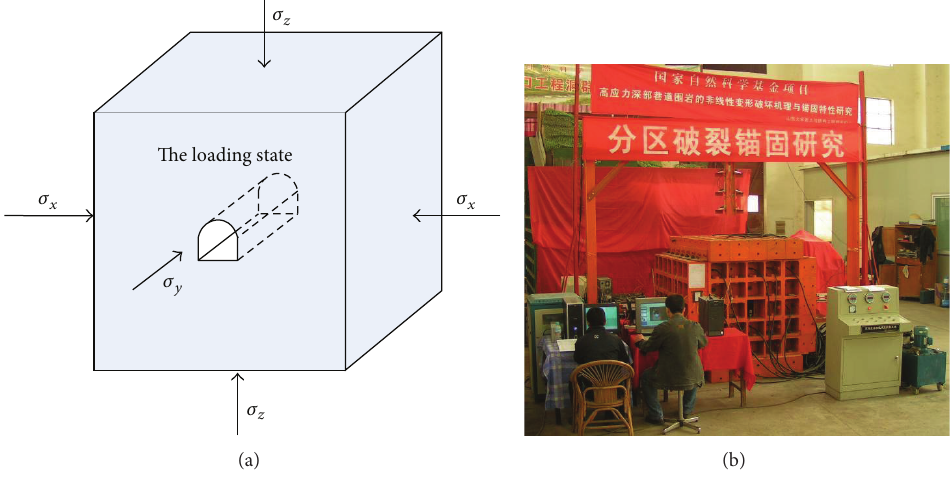
Figure 13: Loading state and test procedure of the